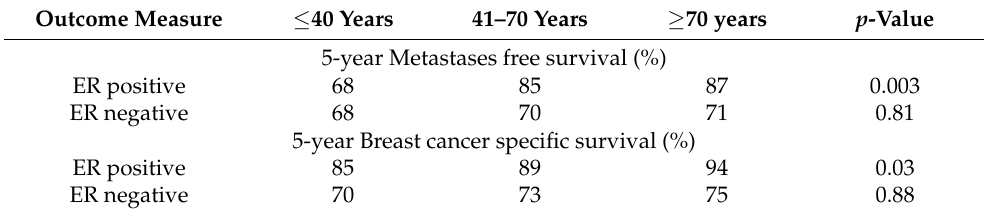
Table 2. Clinical outcome of early operable primary breast cancer—comparison among age groups based on oestrogen receptor status.